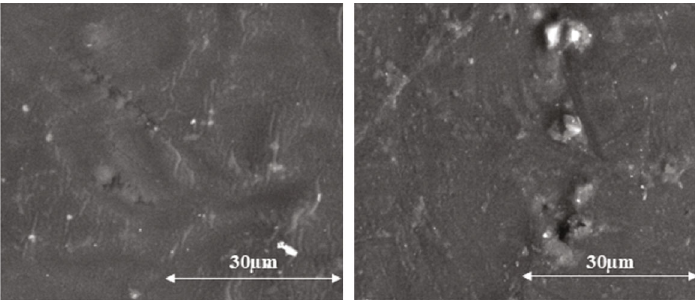
Figure 3: SEM surface morphologies of CRG (carrageenan) hard-shell capsules (a) and CRG-MD/SOR (carrageenan-maltodextrin/sorbitol) hard-shell capsules (b) at 5000 times of magni fi